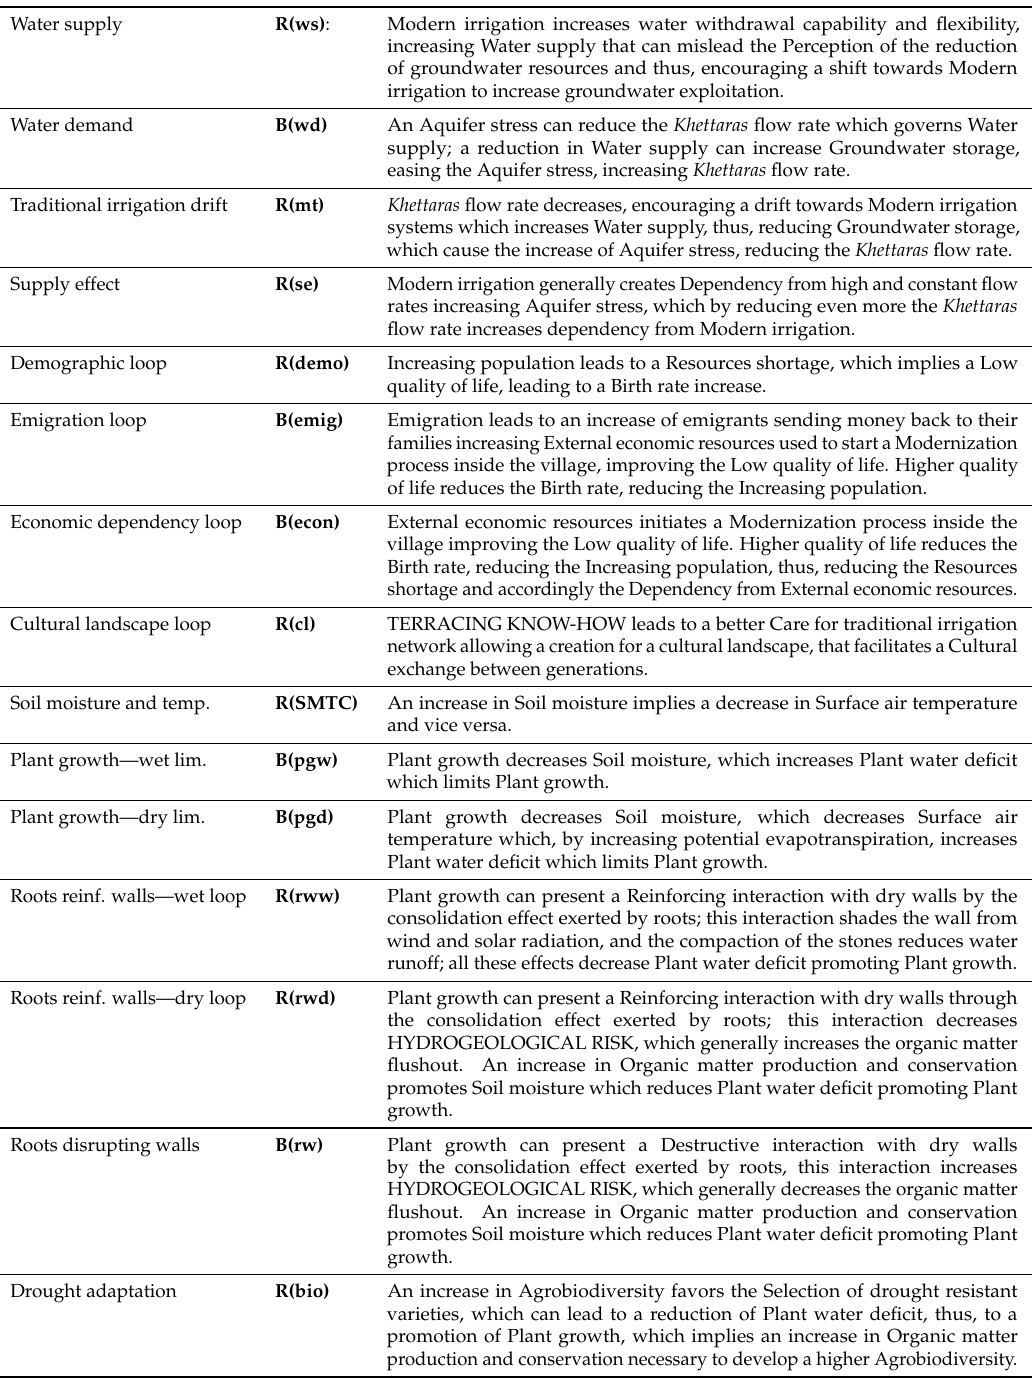
Table 3. Description of loops from Figure